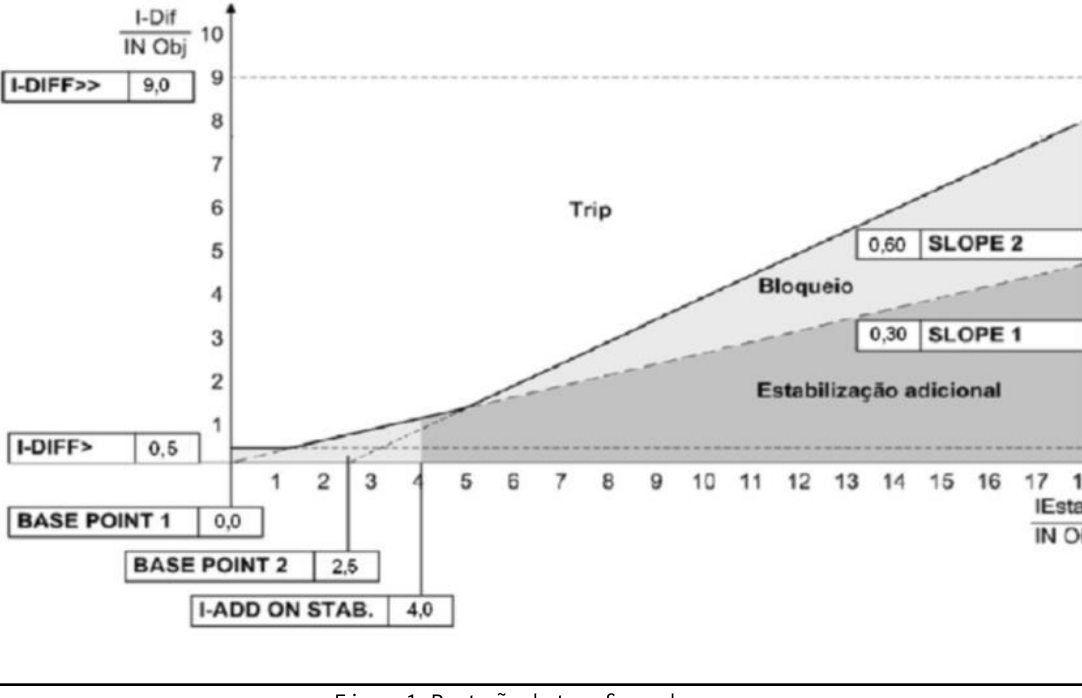
Figura 1: Proteção de transformadores. Fonte: Autor, (2018).